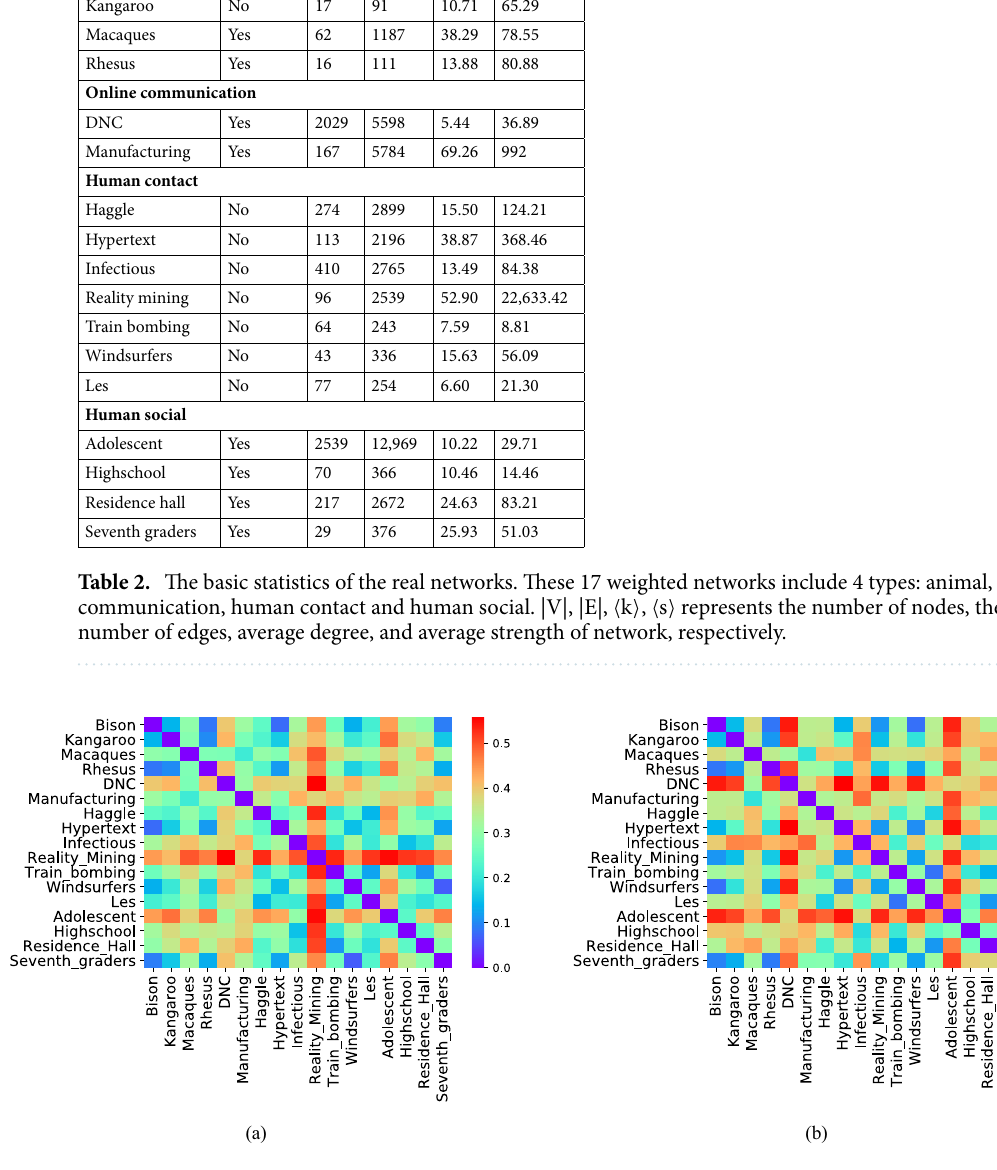
Figure 5. Difference between more weighted real networks. ( a ) Heatmap of the dissimilarity values for each pair of weighted real networks; ( b ) The difference between the real networks when ignoring their